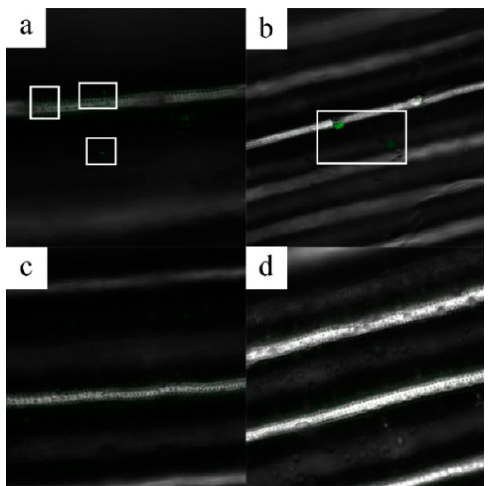
Figure 7. Laser scanning microscopy (LSM) images of rice plants 24 h after MSN-fluorescein isothiocyanate (FITC) treatment. ( a ) Treated plant; ( b ) Treated plant ( c ) Blank plant; ( d ) Blank plant